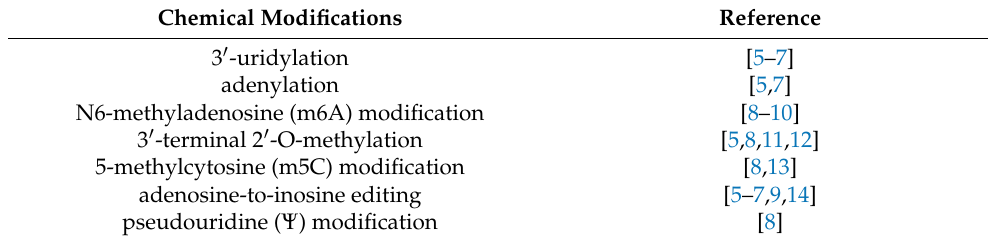
Figure 1. The scheme of cell-free miRNA investigations and their possible implementation. Table 1. Features of the structure of cell-free miRNAs (possible variants of chemical modification).